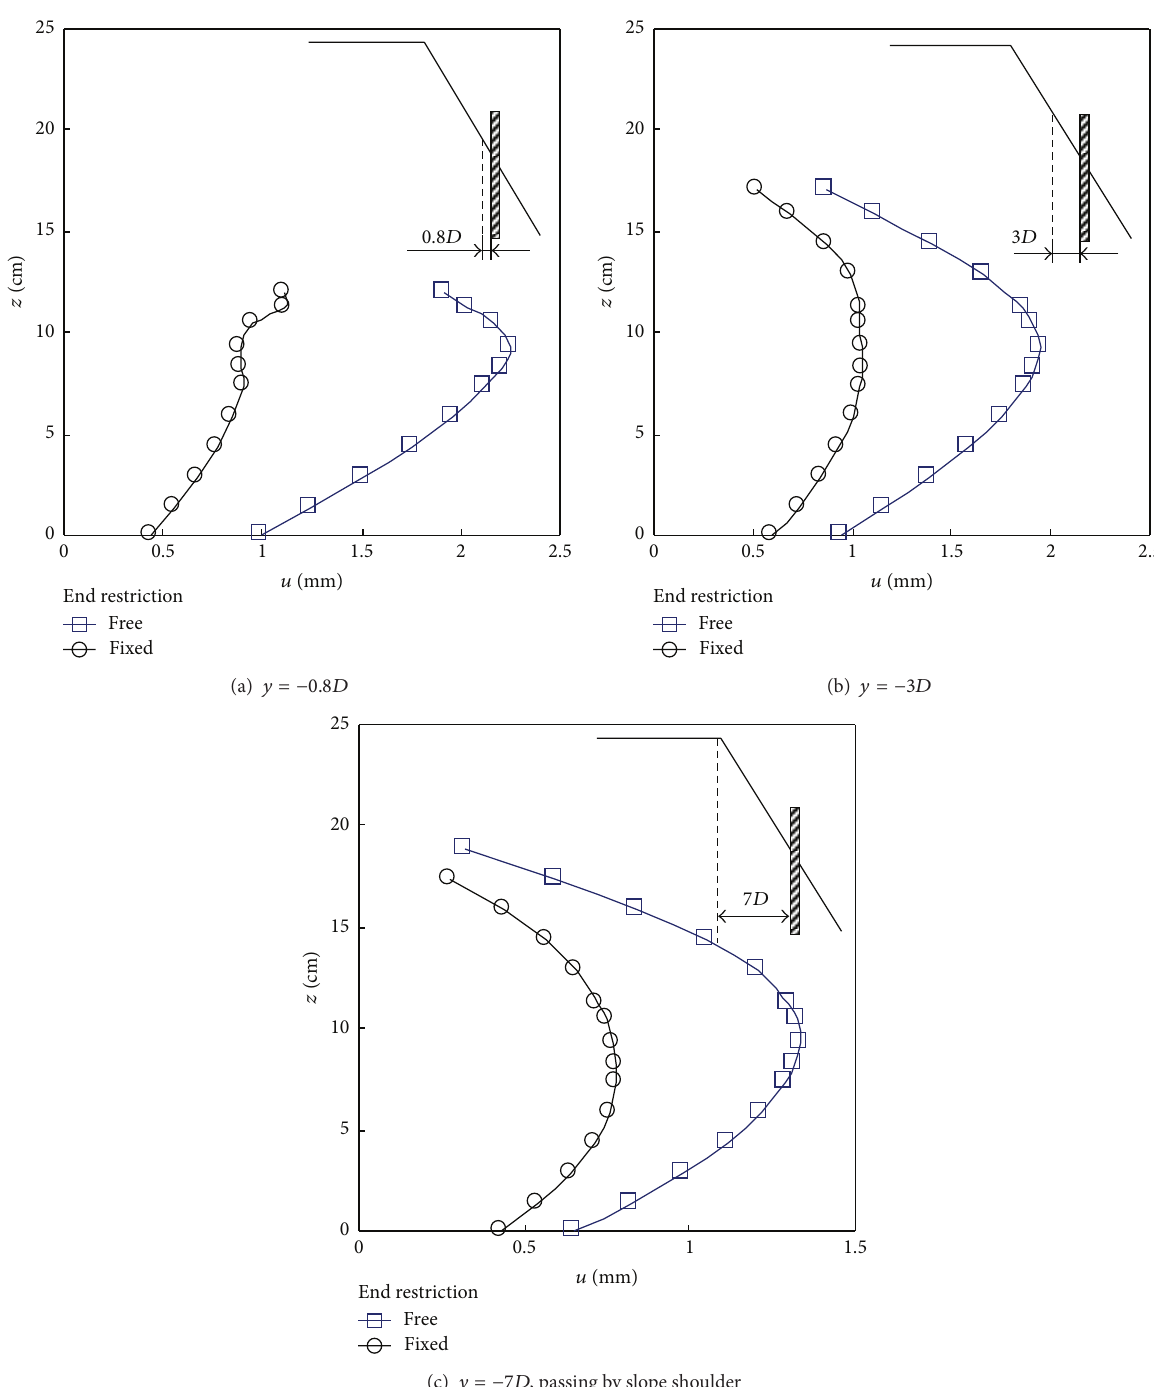
Figure 18: Influence of fixing styles of the pile end by numerical analysis. D : pile diameter; u : horizontal